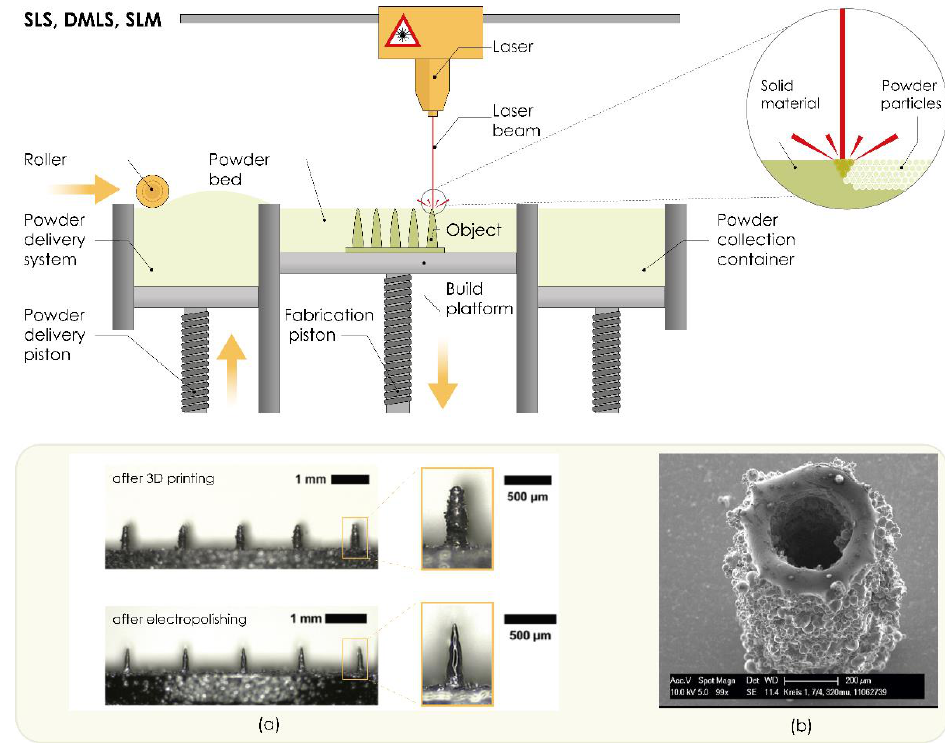
Figure 6. The working principle of powder bed technologies (selective laser sintering, SLS; direct metal laser sintering, DMLS; and selective laser melting, SLM). ( a ) Fabrication of microneedle arrays using DMLS and post-processing by electropolishing. Reproduced with permission from [156], John Wiley & Sons — Books, 2020. ( b ) Fabrication of hollow microneedle using SLM. Reproduced with permission from [158], Walter de Gruyter and Company, Berlin, Germany, 2012 . The image was created with Adobe Illustrator CC (Version 23.0.1.; Adobe Inc., San Jose, CA, USA, 2019). Krieger et al. [156] used a DMLS 3D printer to produce solid MNs from a medical- grade 316 L stainless steel powder. Although MN dimensions in the specified design input file were 1000 μm in height and 250 μm in base diameter, it was noticeable that printed MNs were significantly shorter (657 ± 16 μm). Since printed MNs were not sharp and had a rough surface, the MNs were post-processed by electropolishing (Figure 6a). This pro- cess did not affect the height of printed MNs, while electropolished MNs had a smooth surface and satisfactory tip sharpness, as the tip radius was reduced by 62% compared to unpolished MNs (from 51 μm to 19 μm). These MNs were furt her used as an alternative to commercial wet Ag/AgCl electrodes for EMG signal acquisition. The human study in- volved 14 healthy volunteers, who showed good tolerance of MN electrodes for up to 6 h. Future studies are, however, necessary to ensure the safe handling and disposal of sharp MNs, with regard to safety concerns such as biocompatibility of the materials and risk of skin irritation [156]. The working principle of SLM is similar to SLS and DMLS in that the powder is spread by a roller on the building platform and a laser fuses the powder on points defined by CAD design data. Subsequently, the platform is lowered and another layer of powder